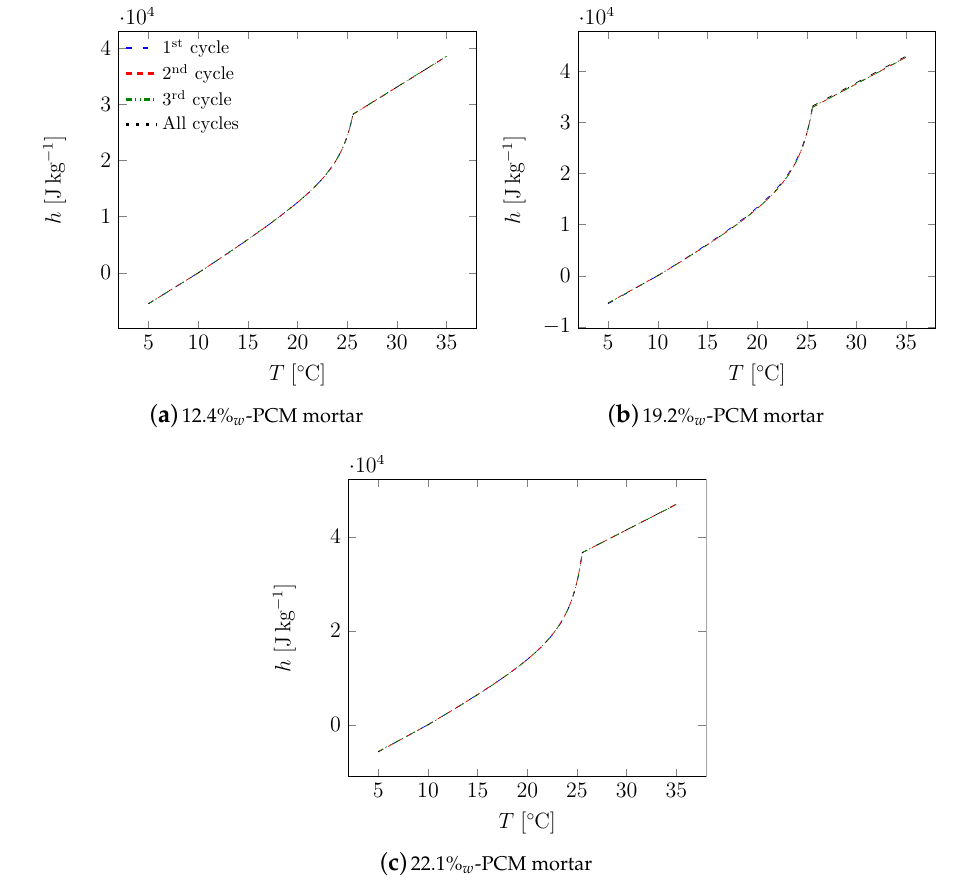
Figure 10. Comparisons of the identified enthalpy functions for all the mortars ( n.b. unique formulation pertaining for both fusion and